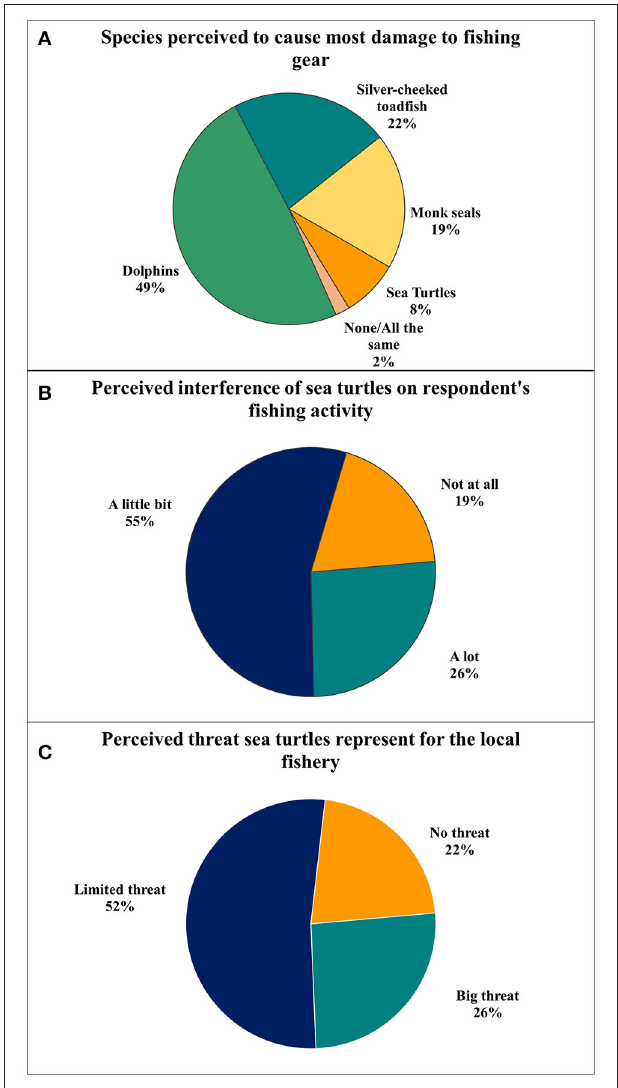
FIGURE 6 | (A) Fishermen of Crete responses regarding which marine vertebrate is perceived to be causing the greatest amount of damage to their gear. Dolphins were perceived to be causing the most damage, with sea turtles ranking lower than all other species. (B) Perceived interference of sea turtles on respondents’ fishing activity. Almost three quarters of respondents believed that turtles interfered with their fishing activity a little bit or not at all. (C) Perceived threat sea turtles represent for the local fishery. Respondents believed that turtles posed a limited or no threat to the local